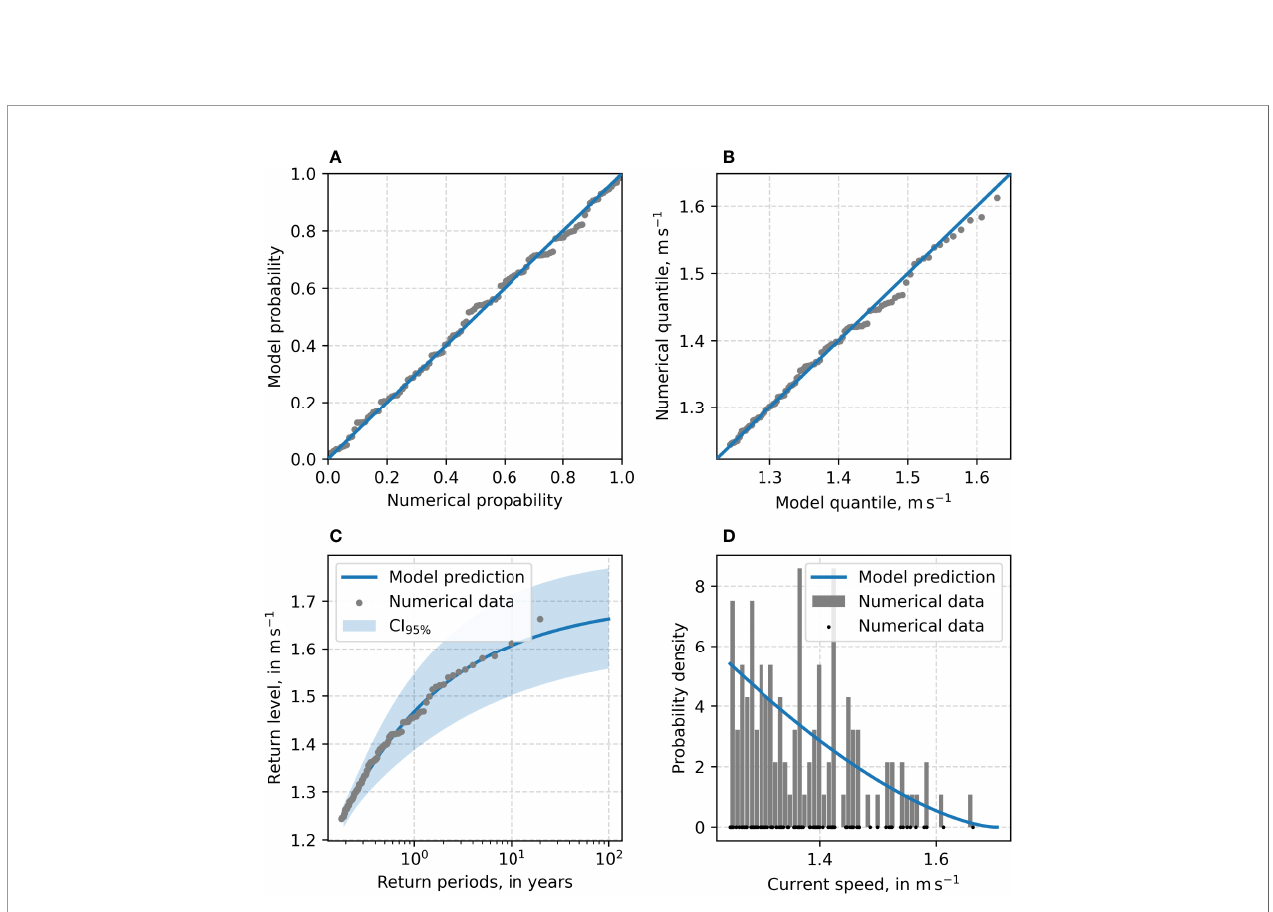
FIGURE 10 | Diagnostic plot for the GPD excess model fi tted to 3-hourly current for the node at P1. (A) p-p plot, (B) q-q plot, (C) return level plot, and (D) density plot.